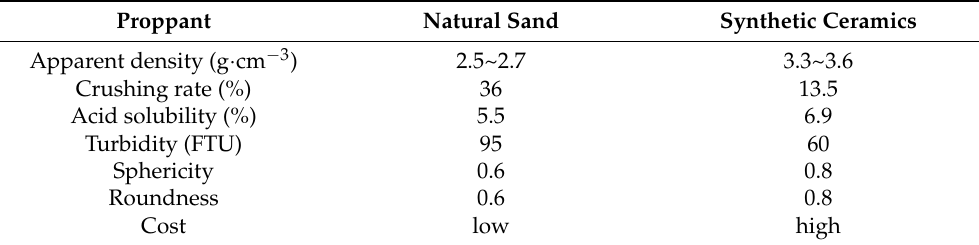
Table 2. Typical properties of natural sand and synthetic ceramic